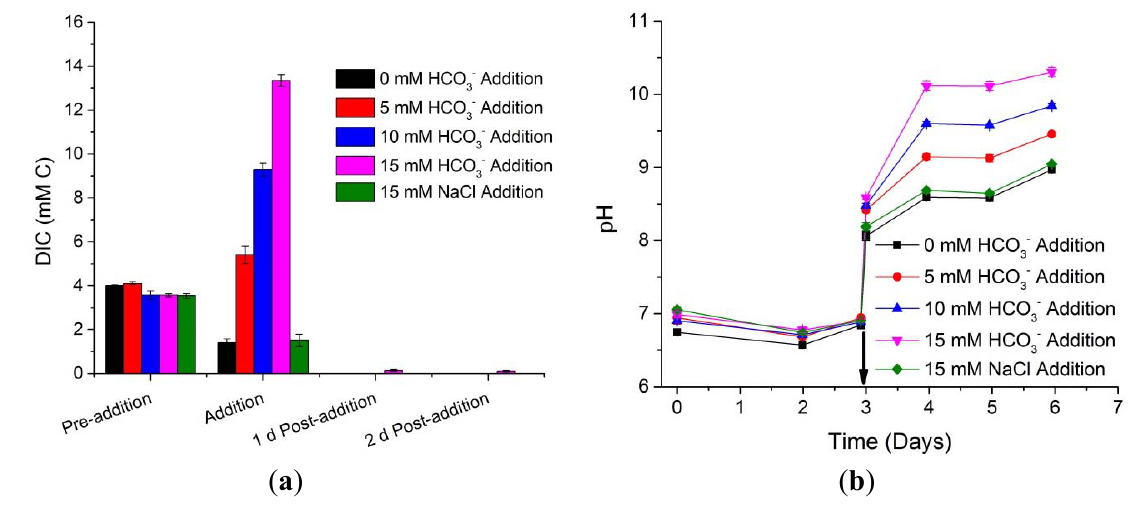
in air and then 2